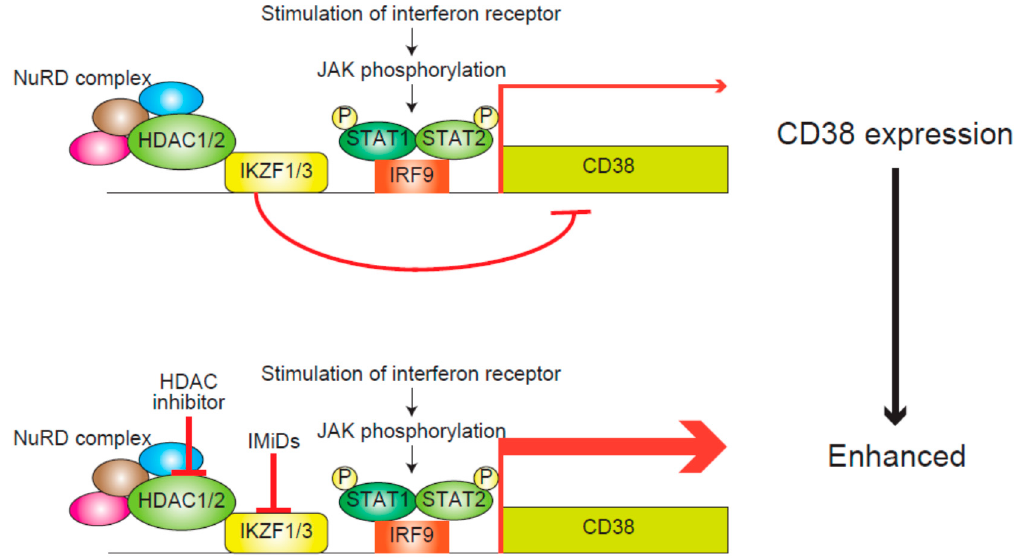
Figure 3. The mechanism underlying the transcriptional regulation of interferon-stimulated genes including CD38 [60]. The interferon-JAK/STAT, IRF9 pathway activates the transcription of interferon-stimulated genes including CD38. In contrast, HDAC1/2 with the NuRD complex synergistically represses those genes in association with IKZF1/3. NuRD, nucleosome remodeling deacetylase; P, phosphorylation.